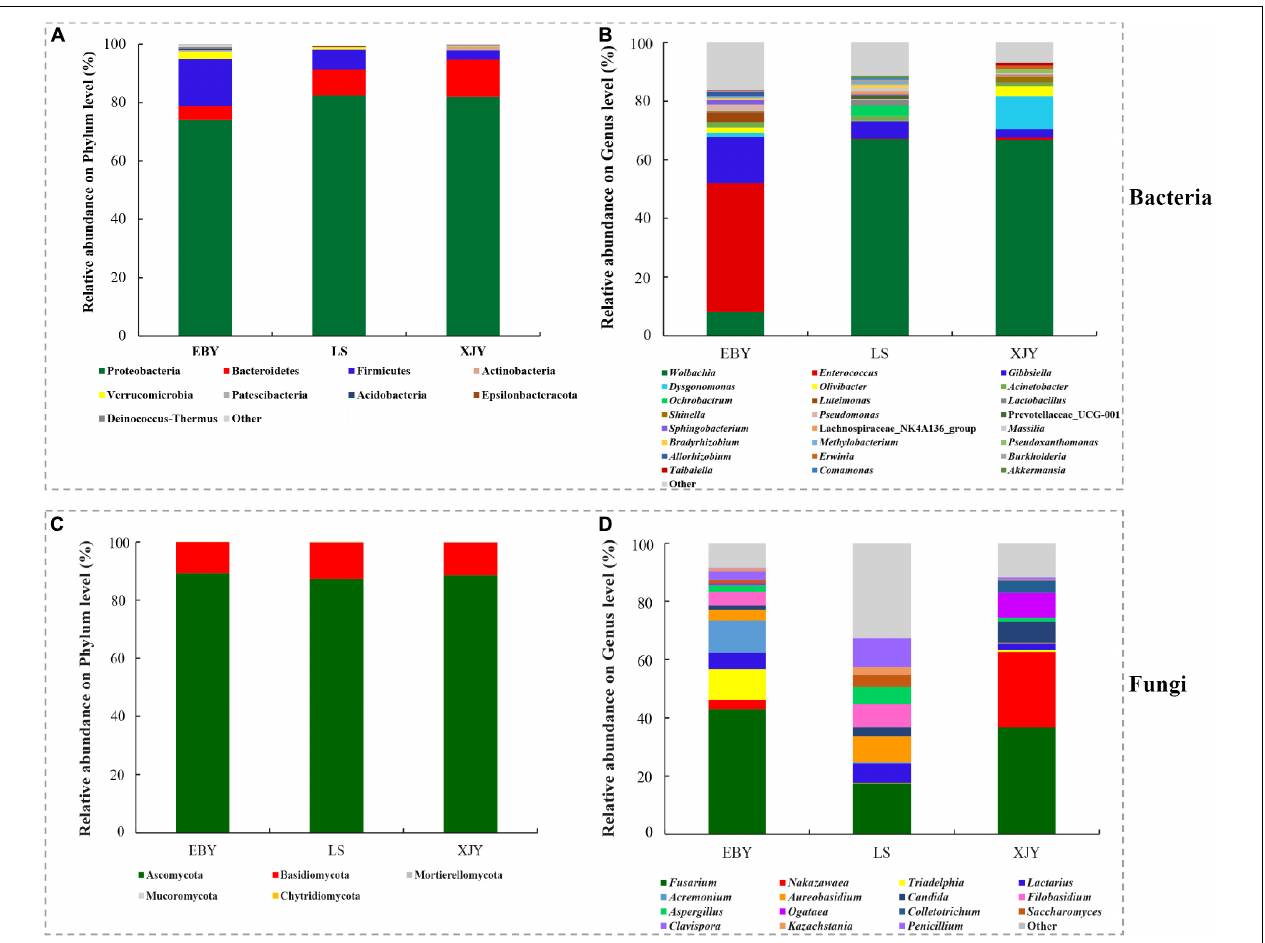
FIGURE 5 | Taxonomic composition of bacterial and fungal communities associated with the A. glabripennis larval gut. The relative abundance is shown for each bacterial (A) phylum and (B) genus. The relative abundance is also shown for each fungal (C) phylum and (D) genus. Each bar is indicated by a different color at the phylum and genus level. OTUs < 1% of the average relative abundance in groups are summarized as “others”. EBY, Populus gansuensis ; LS, Salix babylonica ; XJY, Populus alba var. pyramidalis